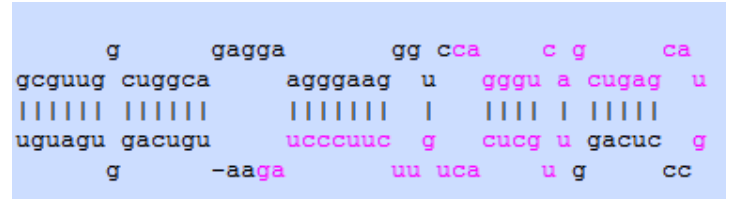
Figure 1: Predicted secondary structure of hsa-mir-1178 (MI0006271) as presented on miRBase, showing stem-loop structure. Pink bases indicate mature miRNA sequences.